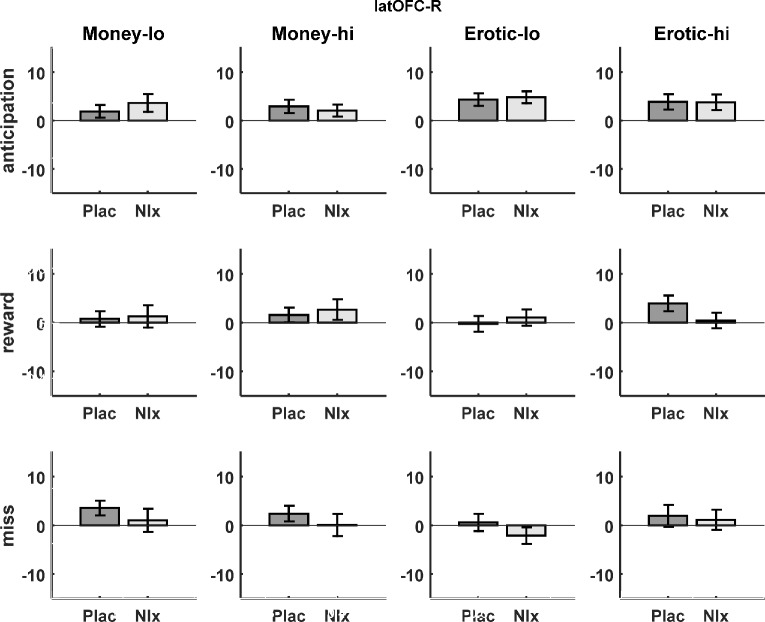
Right lateral orbitofrontal cortex fMRI responses (arbitrary units) for all stimuli (money/erotic, high/low) and time-points (anticipation, outcome: reward, outcome: miss) under placebo (Plac) and naloxone (Nlx).Error bars represent standard error of the mean.